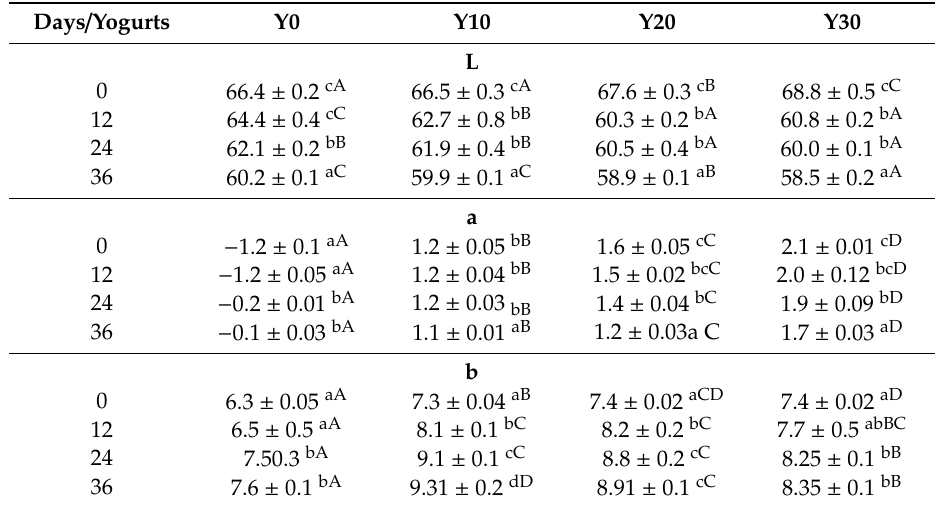
Table 1. Color parameters of L, a y b in different yogurts with different % (w/w) of multiple emulsions during 36 days of storage.